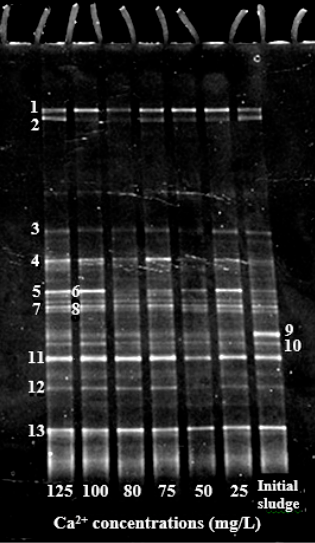
Figure 3. Denaturing gradient gel electrophoresis (DGGE) gel imaging. From right to left, sample 1, initial sludge; Sample 2, (Ca 2+ ) = 25 mg/L; Sample 3, (Ca 2+ )= 50 mg/L; Sample 4, (Ca 2+ ) = 75 mg/L; Sample 5, (Ca 2+ ) = 80 mg/L; Sample 6, (Ca 2+ ) = 100 mg/L; and Sample 7, (Ca 2+ ) = 125 mg/L.